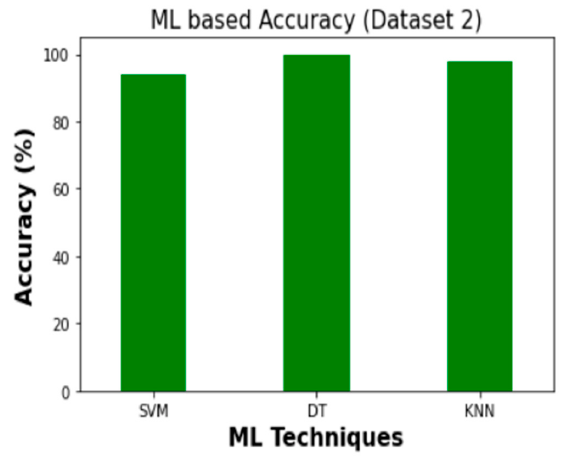
Figure 14. Accuracy comparison (Dataset 1).